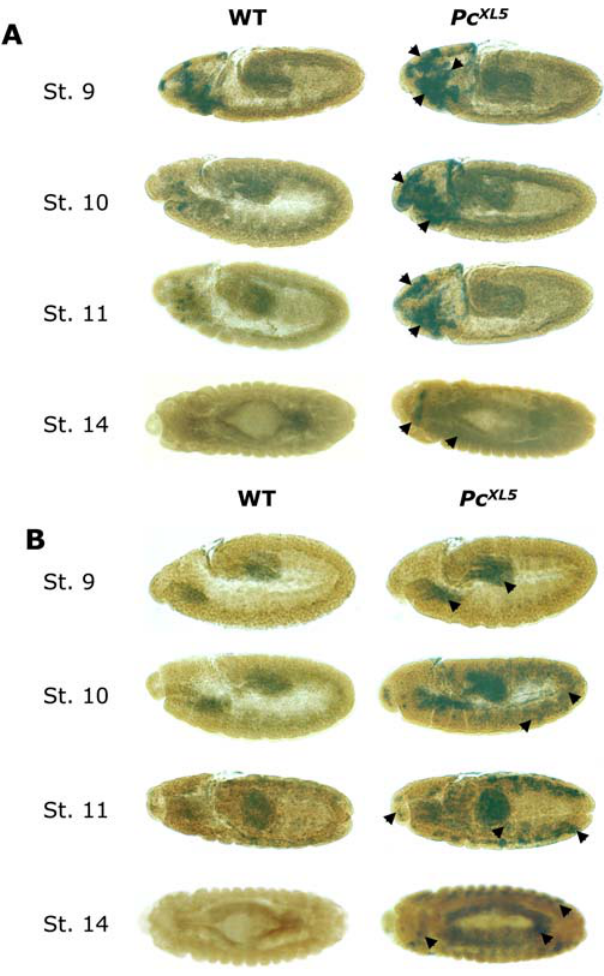
Figure 6. Regulation of Target Genes by PC In situ hybridizations in WT and in Pc XL5 mutant embryos for the gt and peb genes. The developmental stage of the embryos is indicated on the left. Arrowheads indicate regions of increased or ectopic labeling in Pc mutants compared to WT. (A) gt expression at embryonic stages 9, 10, 11, and 14. (B) peb expression at embryonic stages 9, 10, 11, and